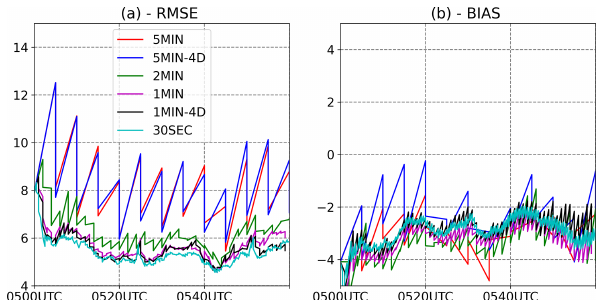
Figure 8. Sawtooth time series of the root mean squared error (dBZ; a ) and bias (dBZ; b ) of the maximum reflectivity of the anal- ysis and first guess for the 5MIN (red), 5MIN-4D (blue), 2MIN (green), 1MIN (magenta), 1MIN-4D (black), and 30SEC (cyan) ex-